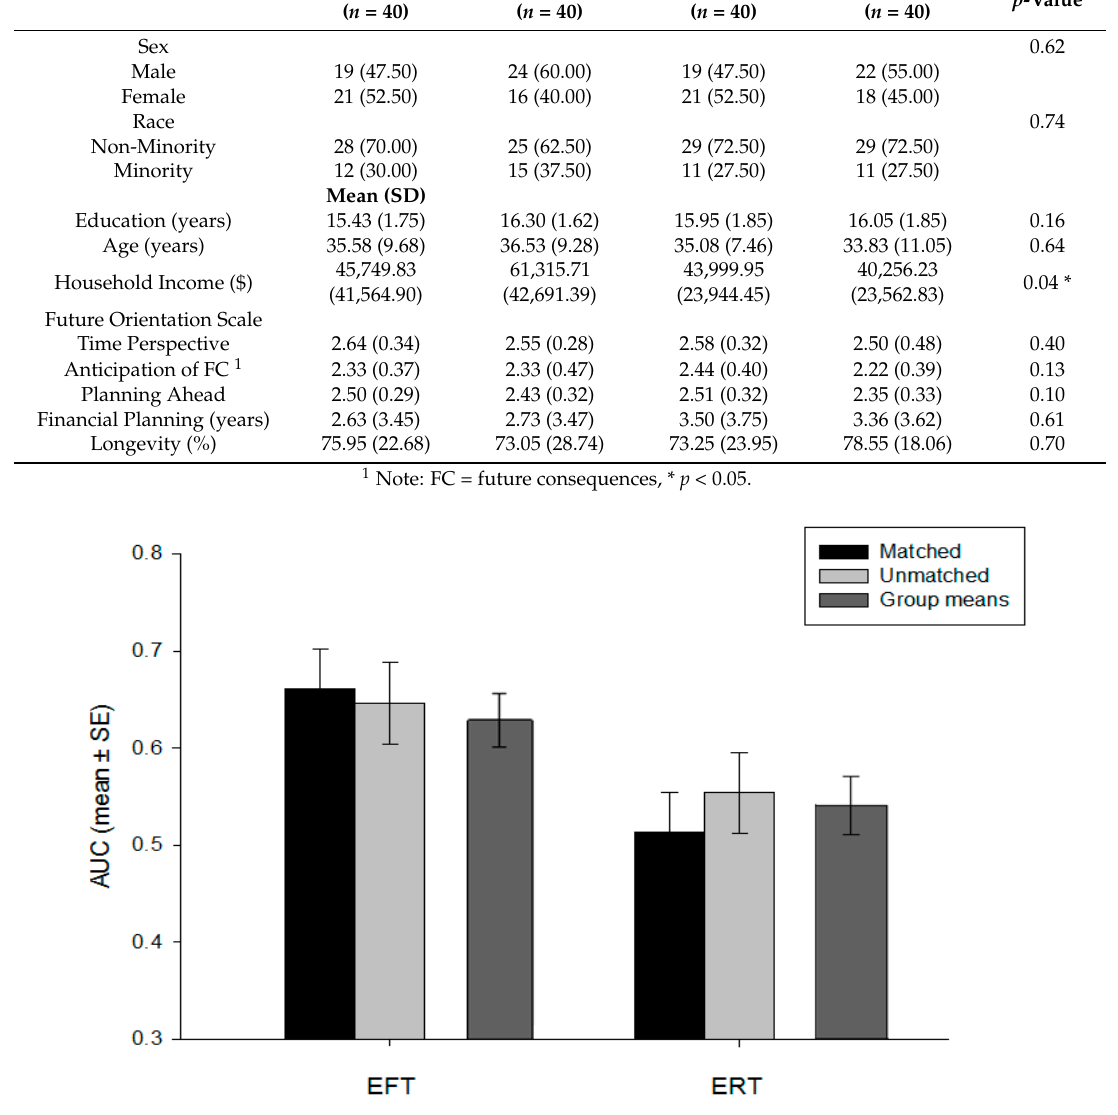
Figure 1. Area under the curve (AUC) values (mean ± SE) for the discounting of delayed rewards as a function of